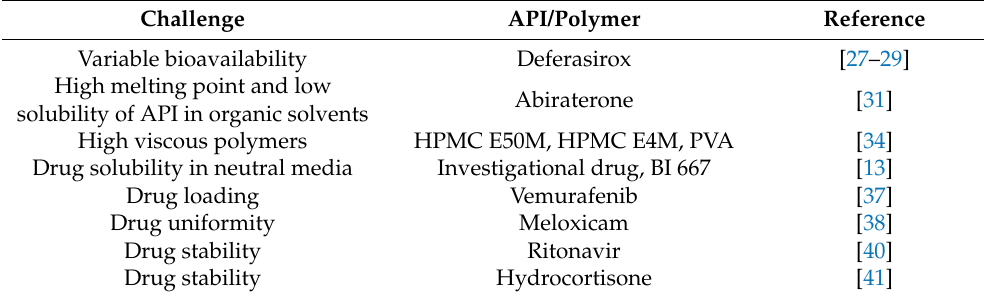
Table 2. List of challenges that were resolved by KinetiSol ® technology in the preparation of